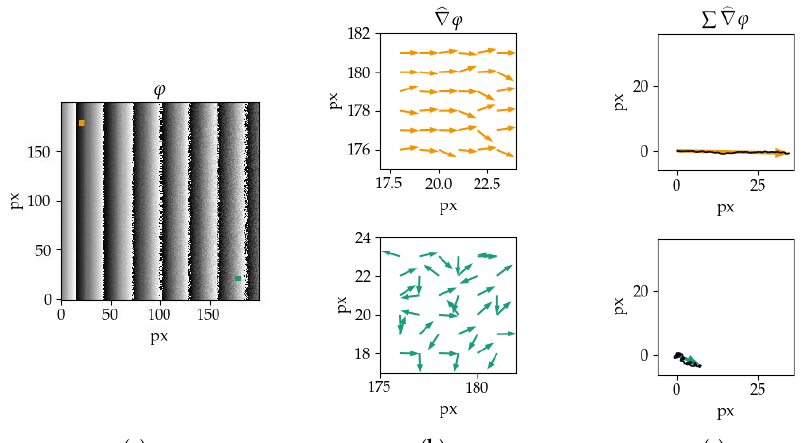
Figure 2. Algorithm principle from phase map input to phase noise output. ( a ) Simulated phase map with linearly increasing noise from left to right; ( b ) phase gradient direction for low-noise and high-noise points in a 6 × 6 px 2 area; and ( c ) sum of gradient direction vectors ∑∇̂𝜑 for low-noise (top) and high-noise (bottom) points. A long sum vector indicates an area of smooth phase.